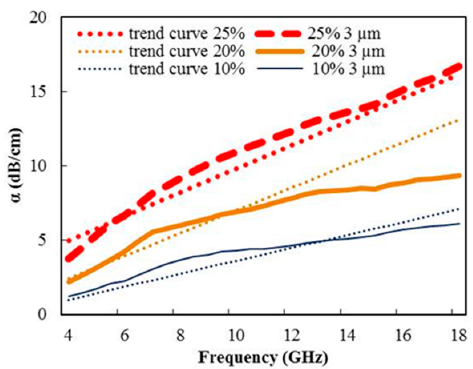
Figure 7. Electromagnetic absorption α vs. epoxy resin loaded with a 3-µm graphene particle size with various weight ratios.